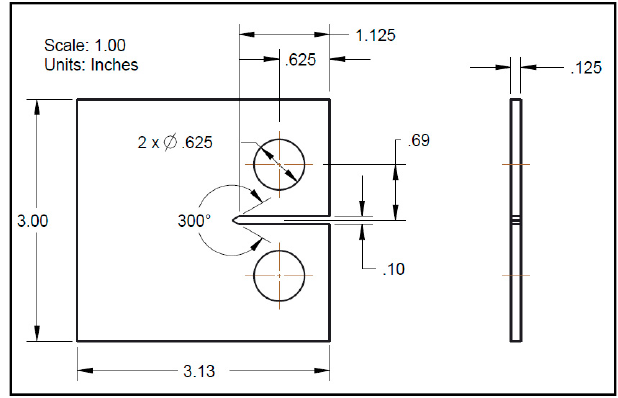
Figure 2. Technical drawing of the CT specimen (dimensions in inches).